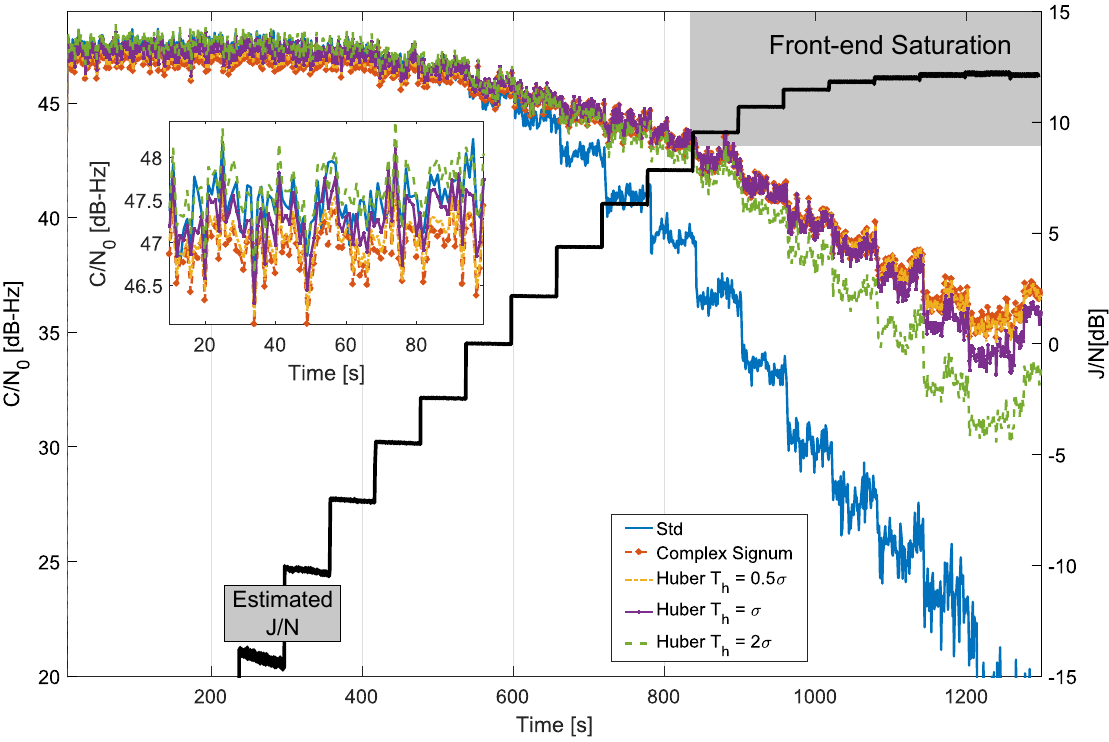
Figure 9. Comparison of C / N 0 values obtained considering different time domain processing schemes. Anechoic chamber test with Galileo E1c